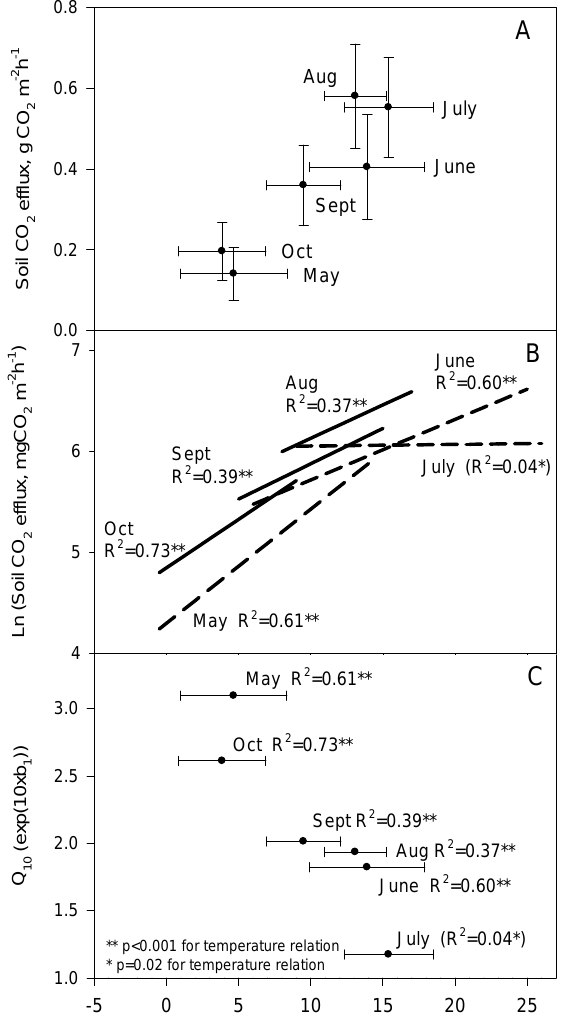
measurements)-5 0 Tsoil (mean temperature at the moment of flux Fig. 5. (A) Means for soil CO 2 efflux and soil temperature for monthly subsets of three-year data (1997–1999). Error bars rep- resent standard deviation. Number of observations varied from 50 (May) to 126 (July). (B) Month-specific temperature-response models based on three-year data (1997–1999). Models formu- lated as LnFlux = b 0 + b 1 × T soil . (C) Q 10 calculated as Q 10 = e 10 × b 1 , b 1 from the temperature-response model formu- lated as LnFlux = b 0 + b 1 × T soil . Constants, b 0 ’s were 4.302 (May), 5.121 (Jun), (6.042 (Jul)), 5.475 (Aug), 5.182 (Sep), and 4.851 (Oct). Regression coefficients, b 1 ’s, did not differ